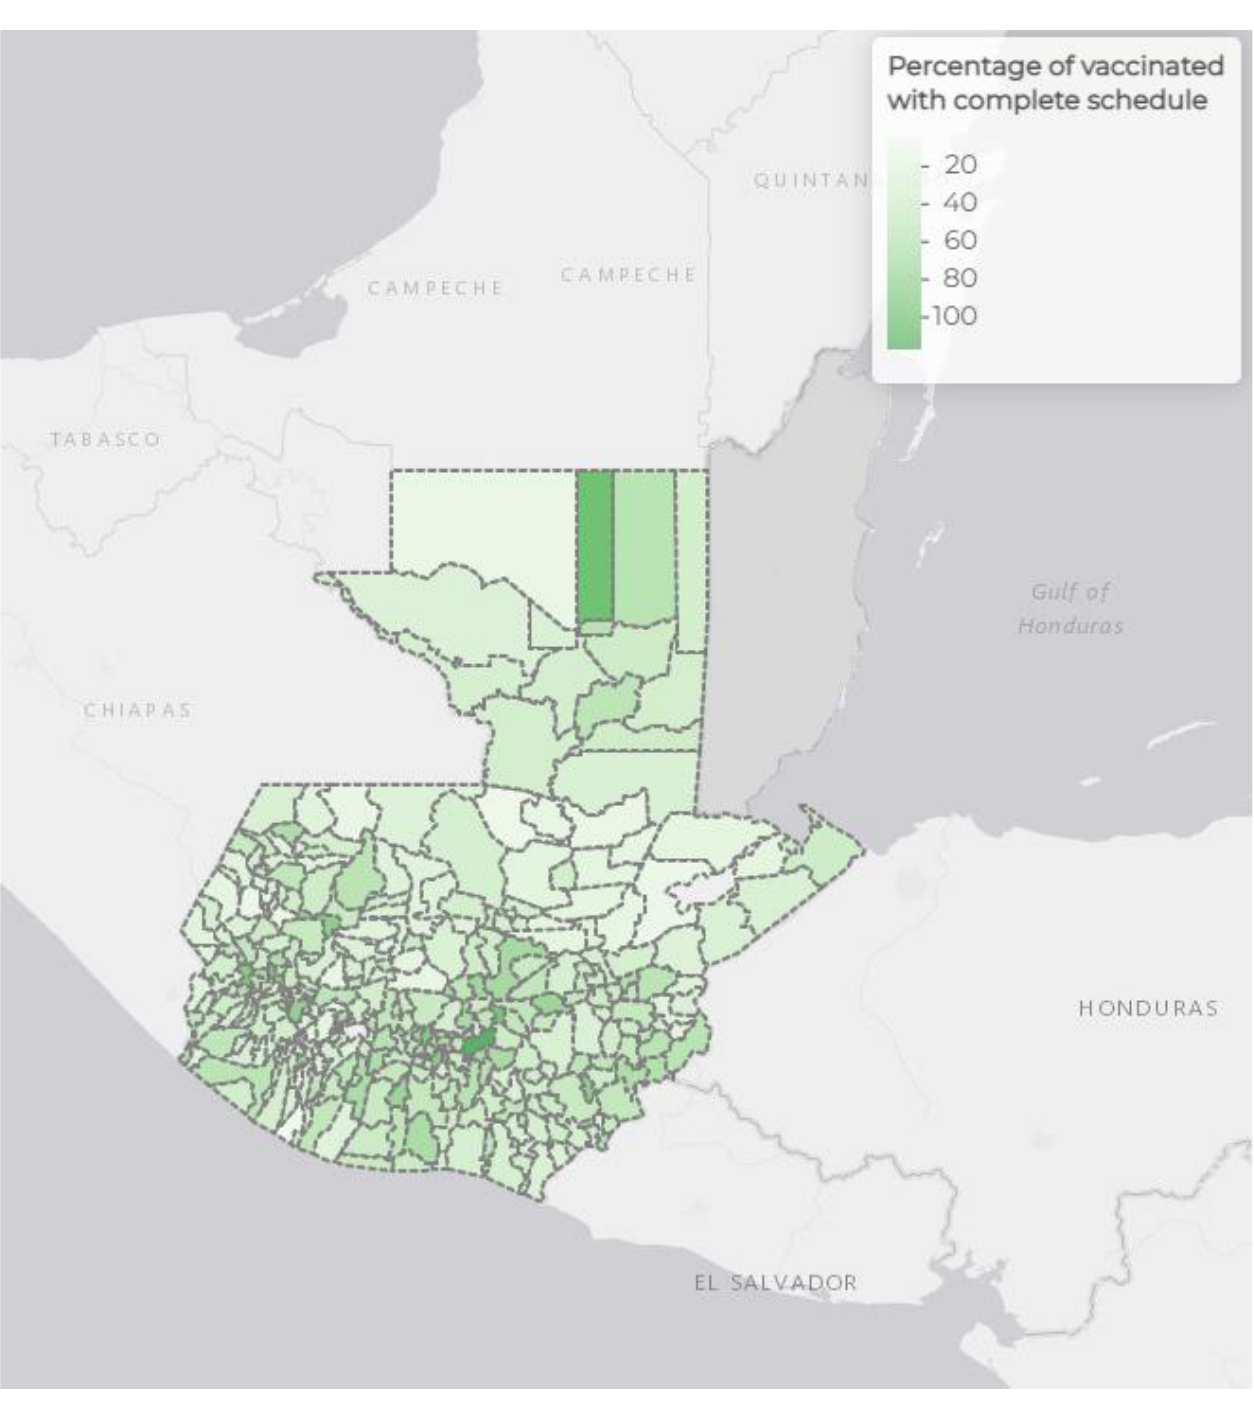
Figure 2. Primary COVID-19 vaccination series coverage by municipality in Guatemala. Image adapted from Guatemala Ministry of Health and Social Assistance, 25 February 2021 to 30 November 2022